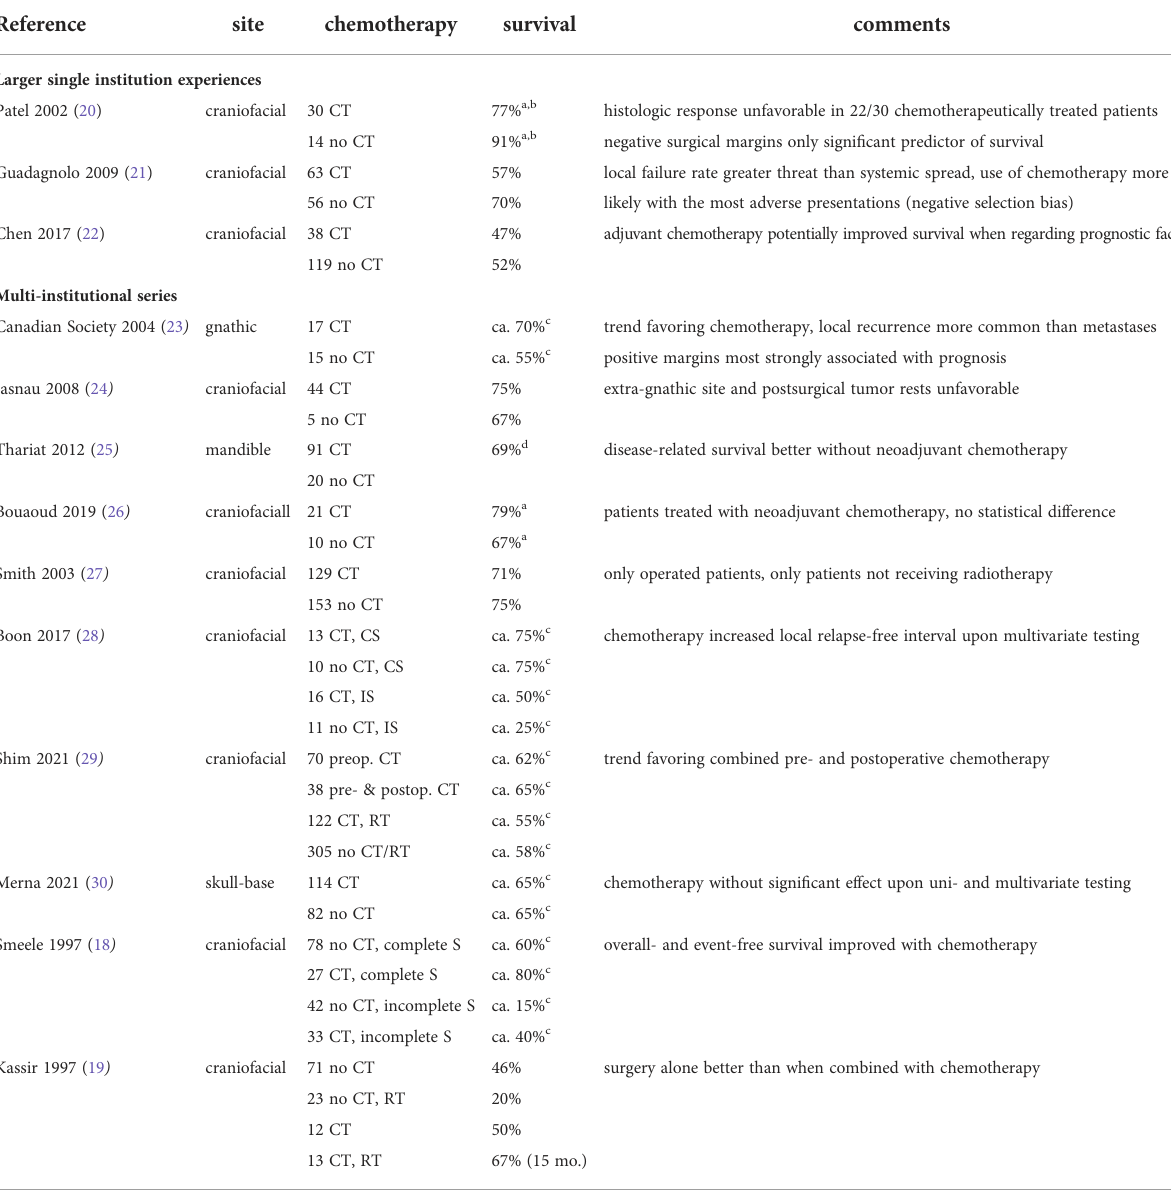
TABLE 1 Five-year survival of patients with craniofacial osteosarcoma receiving or not receiving